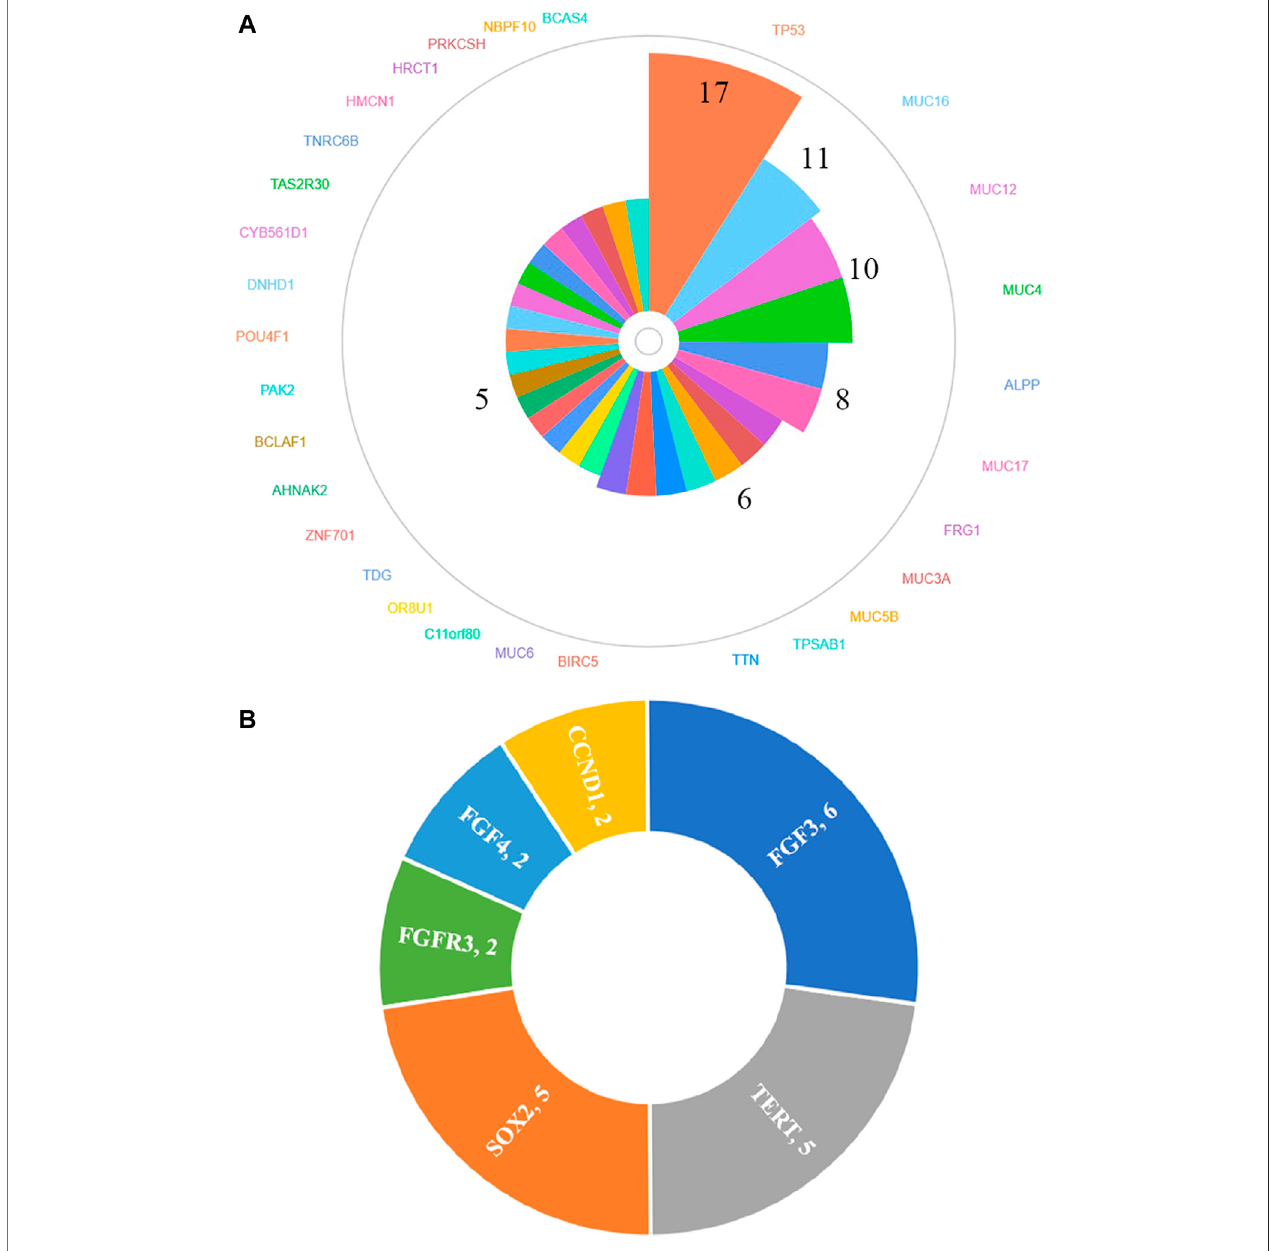
FIGURE 2 | Genes of high-frequency sequence variants (A) and CNV (B) detected by whole-exome sequencing.